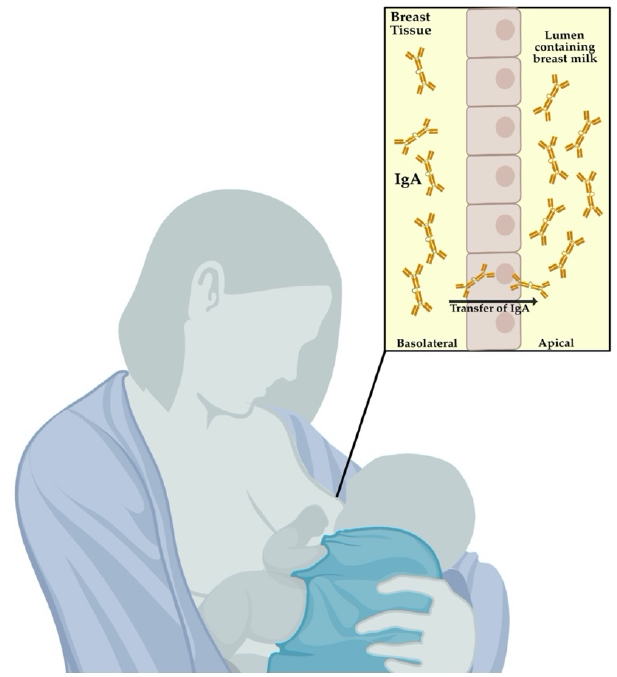
Figure 2. Another crucial mechanism of vertically transferred immunity during pregnancy is the transfer of secretory IgA via breast-milk post-birth. IgA1 and IgA2 are the main subtypes transferred to the infant, with IgA1 being crucial for protection against influenza virus infection. This figure was created with Bio Render and Affinity